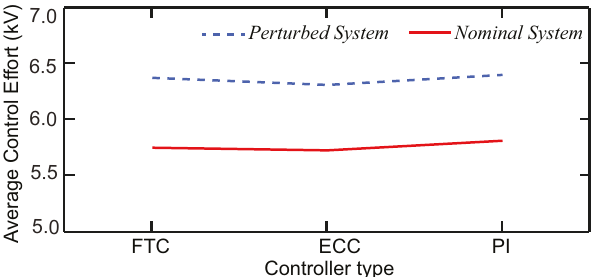
Figure 10. Average control efforts of the FTC, the ECC, and the PI controller for nominal and perturbed systems.